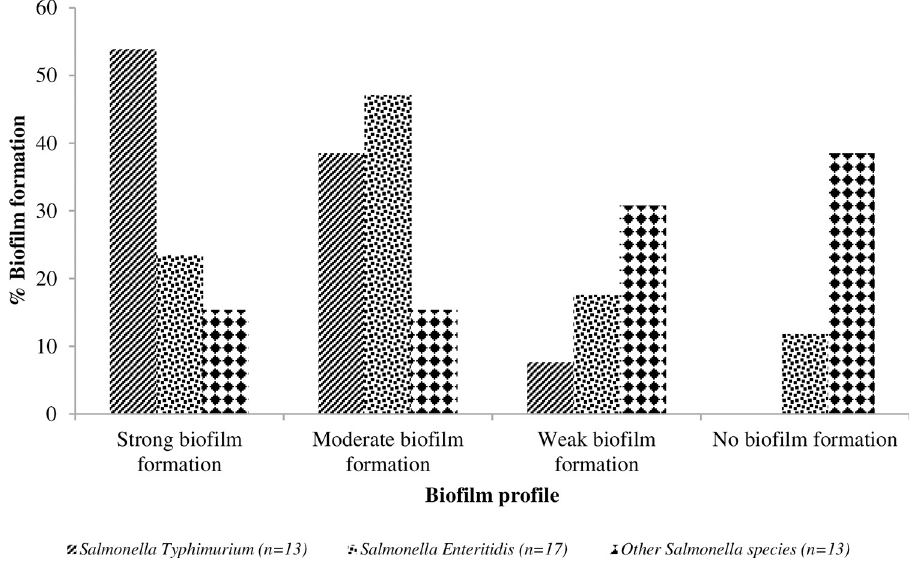
Fig 4. Biofilm formation profile of the Salmonella